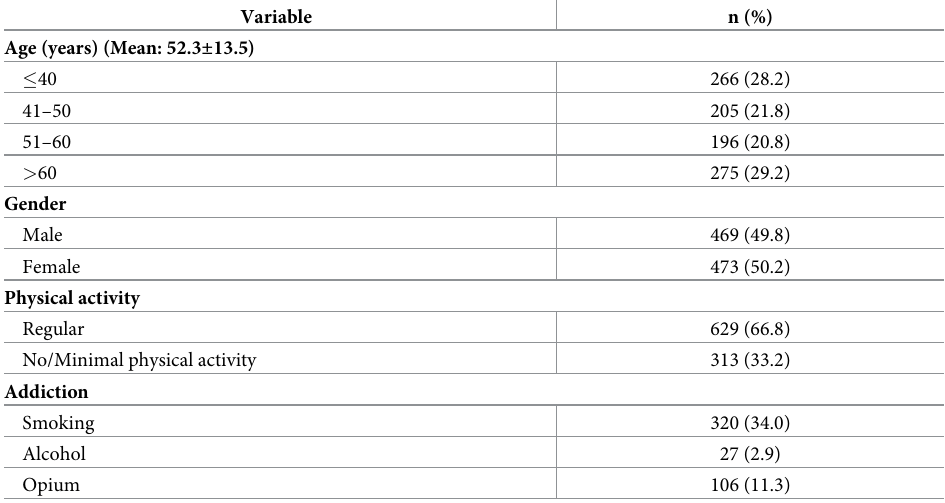
Table 1. Sociodemographic and behavioral characteristics of the study participants (n =